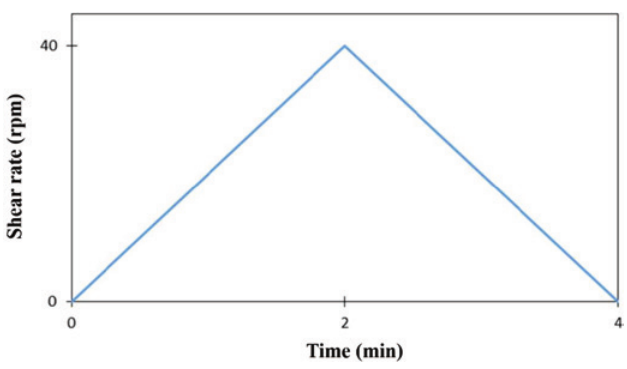
Consistency index (spread on flow table) of the cementitious matrices as a function of the GD content added